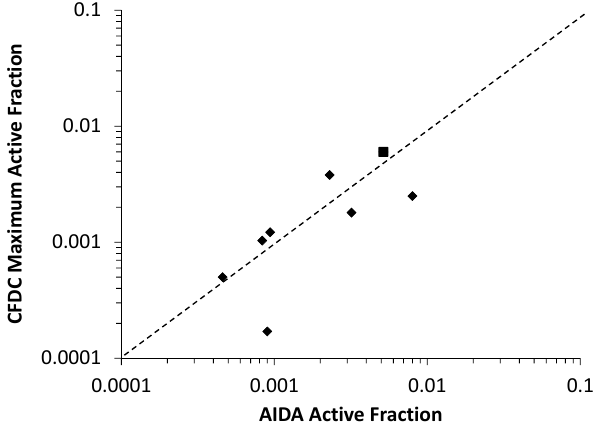
Figure 9. Comparison of CFDC maximum INP active fraction and AIDA cloud expansions active fractions for common experiments when the CFDC sampled from the AIDA chamber prior to first ex- pansion. The square point is for an experiment using Snomax ™ par-